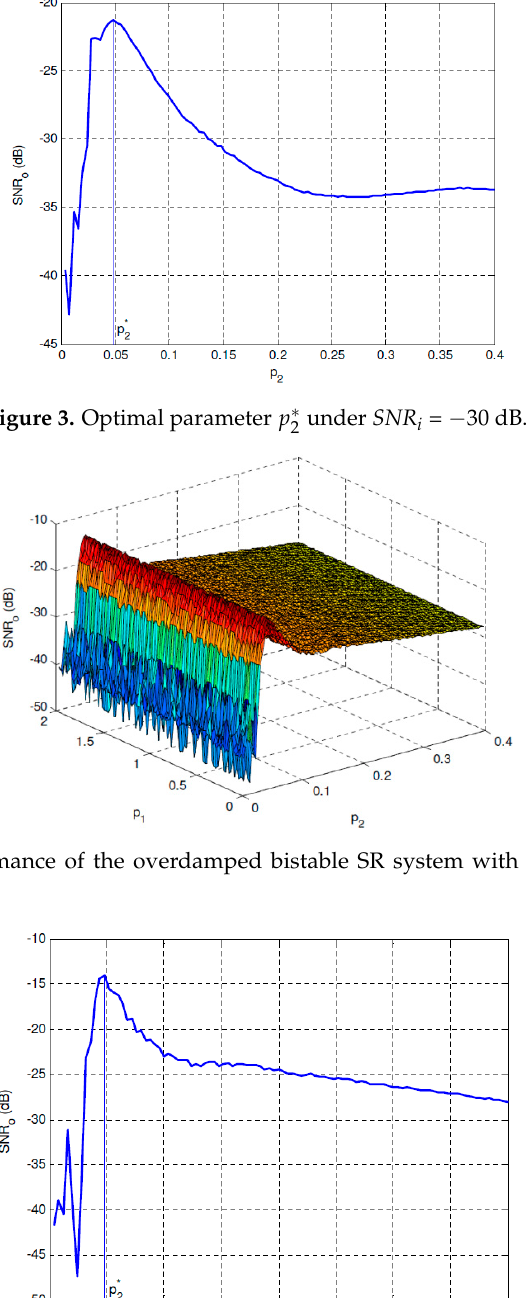
* p under SNR under SNR i = − 25 * p under SNR 2 2 2 * p under SNR 2